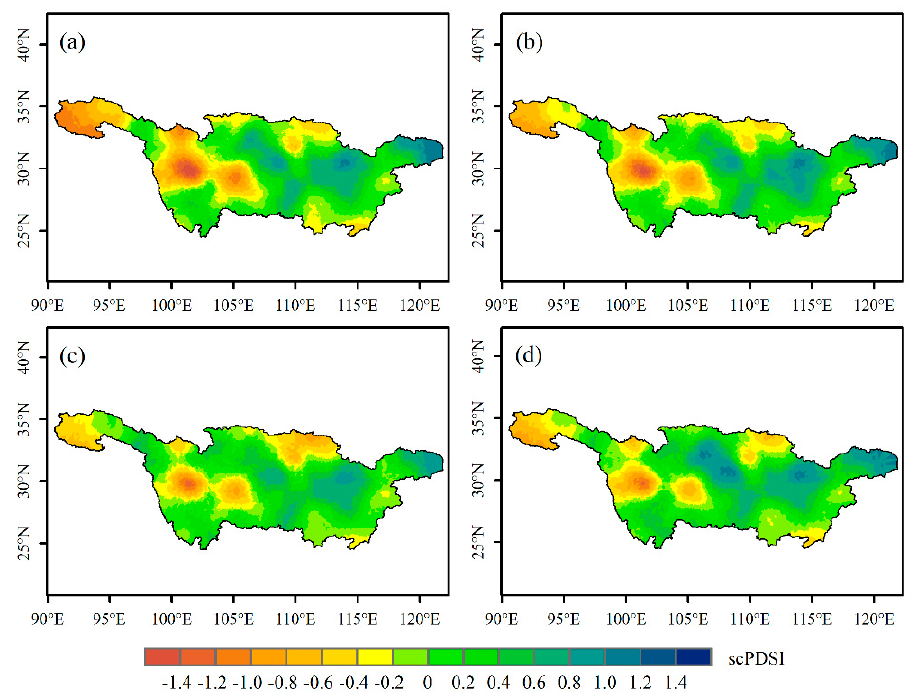
Figure 4. Distribution of scPDSI in different seasons in the YRB for the period 1980–2019. ( a ) Autumn, ( b ) winter, ( c ) spring, ( d ) summer.